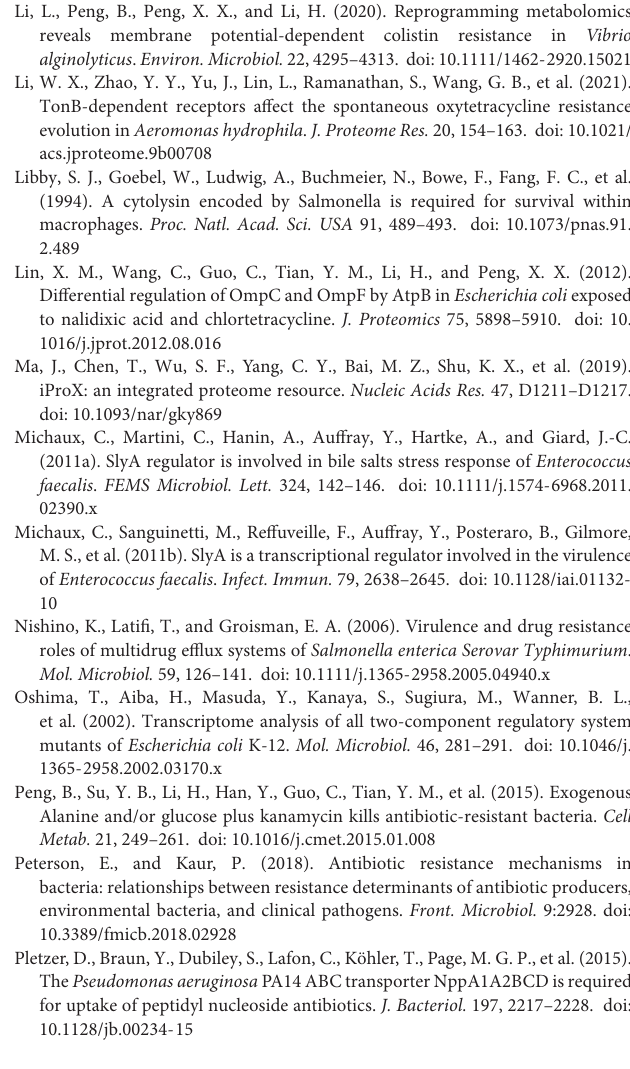
Supplementary Figure 1 | Construction and confirmation of the six gene deletion strains. Supplementary Table 1 | The identification of 14 common altered proteins between both group comparisons using label-free analysis. Supplementary Table 2 | The primer pairs used in this